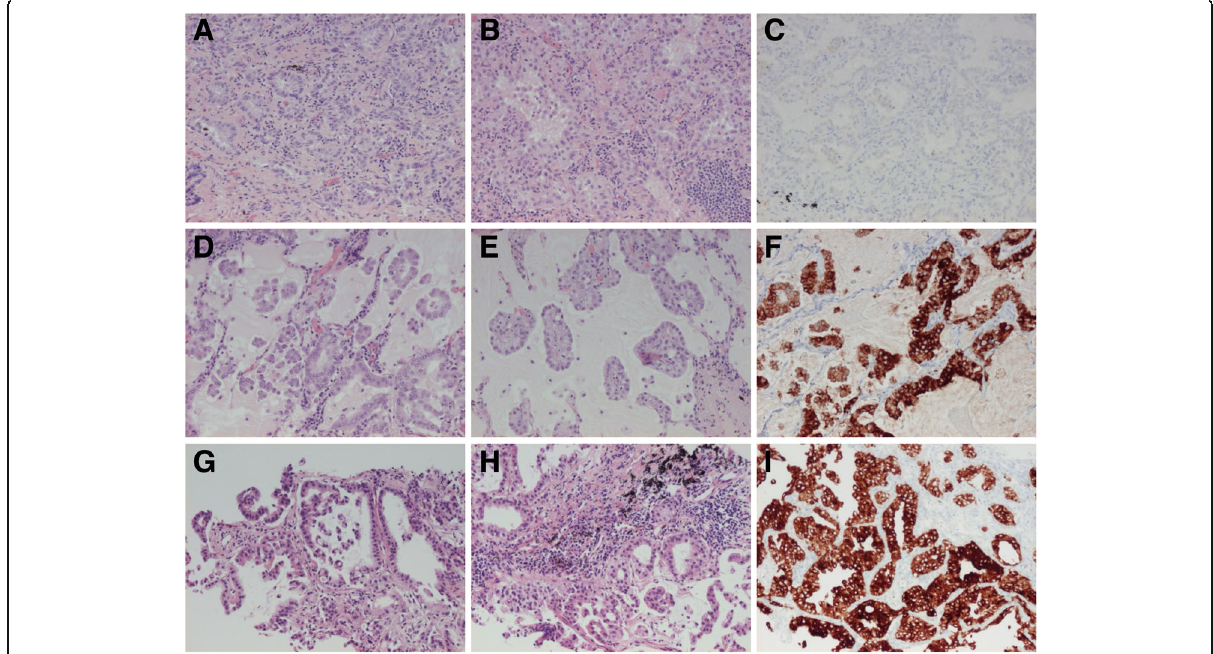
Fig. 6 Case 6. Synchronous lung adenocarcinomas in right upper and lower lobes with different growth patterns and different genetic profiles with the contralateral metastasis from the latter. ( a - c ) The EGFR mutated right upper lobe tumour with acinary growth pattern. ( d - f ) The right lower lobe tumour with micropapillary (predominant), acinary and papillary growth patterns. ( g - i ) The metastasis to the left lower lobe. ( a - b , d - e , g - h ) HE, ( c , f , i ) ALK. All images x10